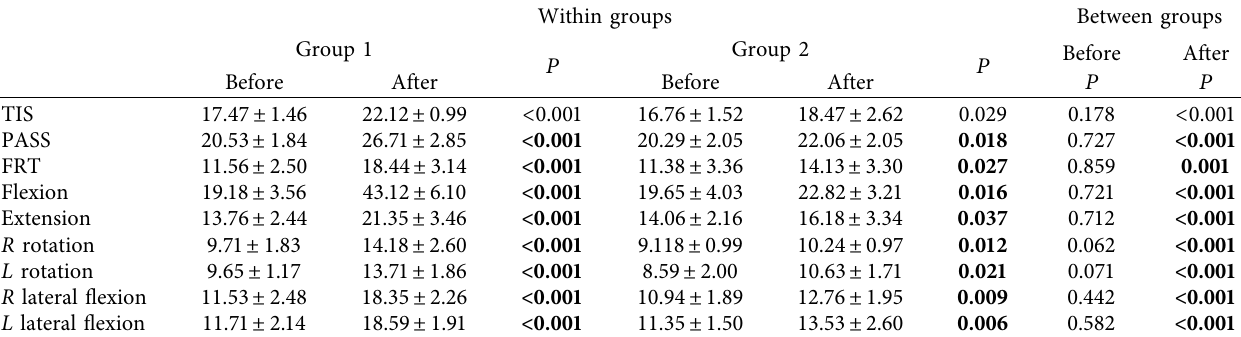
Table 2: Within and between group comparison of the mean values of the measured trunk range of motions in degrees. Within groups Between